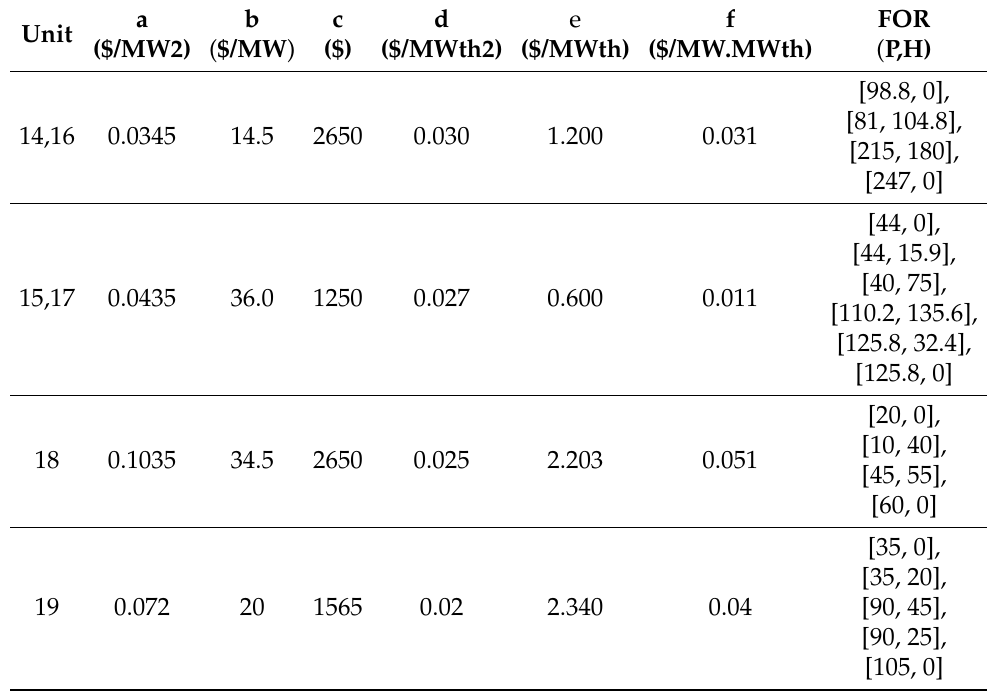
Table A11. Cogeneration unit data for Case Study 4.